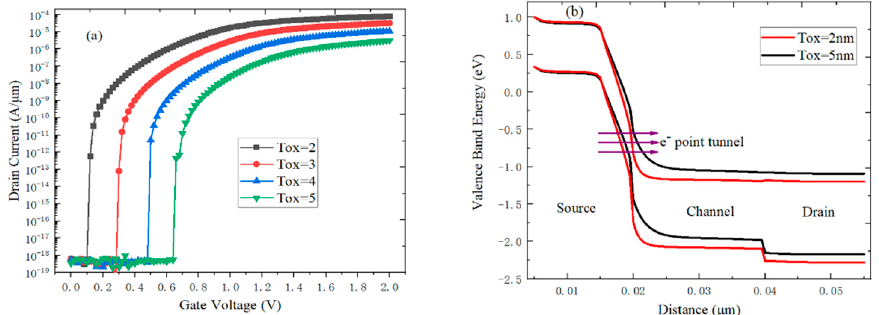
Figure 6. ( a ) Influence of T ox on the transfer characteristic; ( b ) on-state energy band at the surface of channel from the source to the drain.